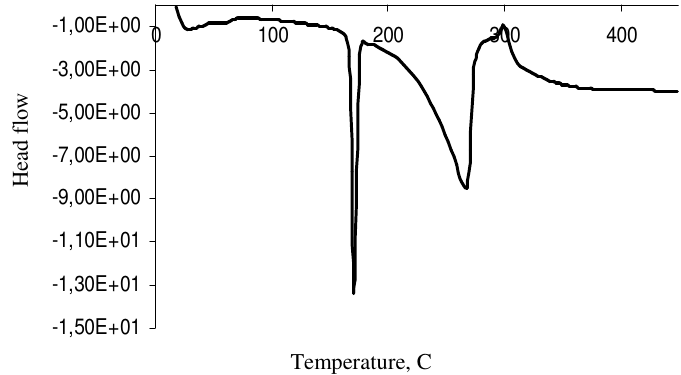
Figure 3a. DSC of